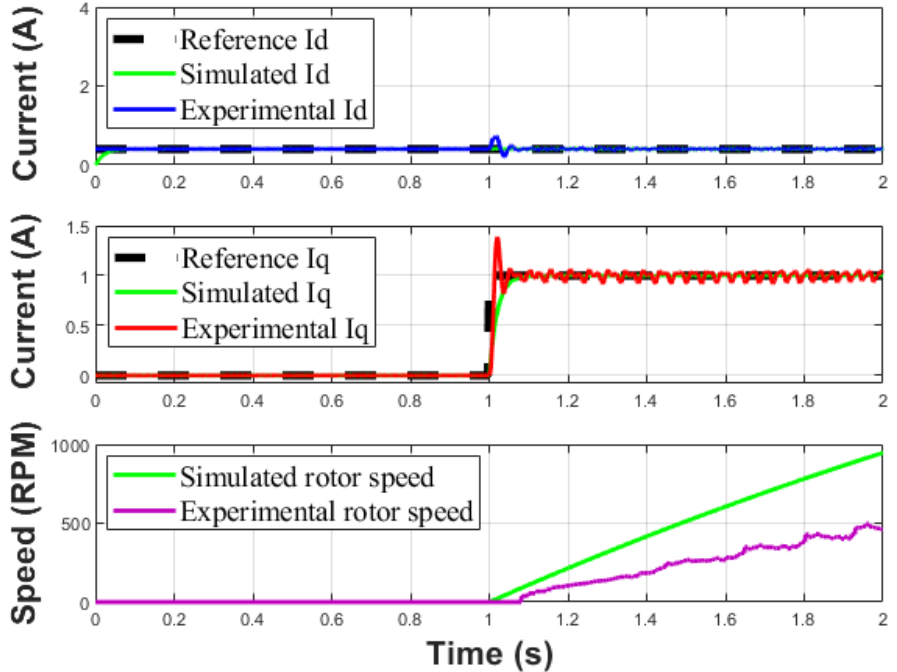
Figure 19. Current control loop behavior for i ∗ q = 1.0 A.